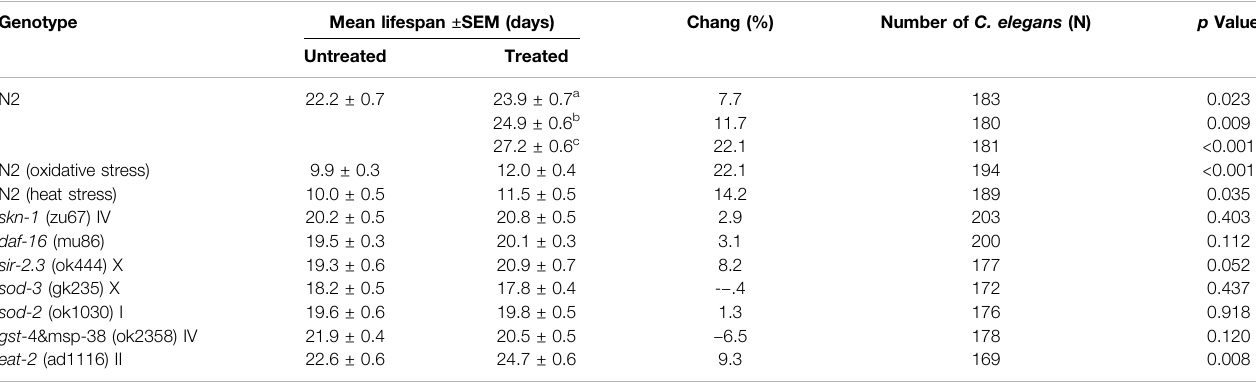
TABLE 1 | Effects of TLB on the mean lifespan of C. elegans .